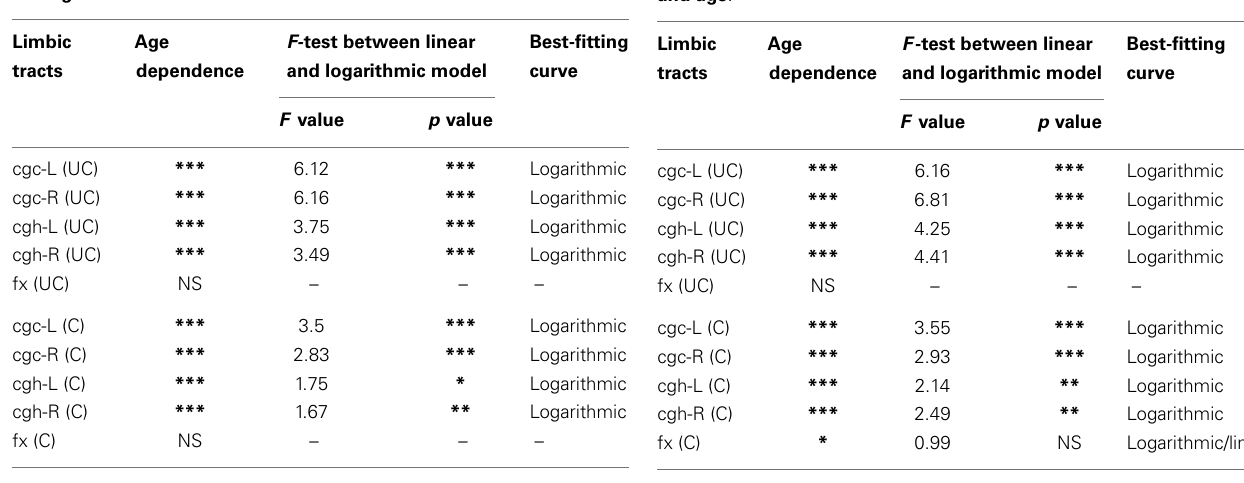
Table 2 | Relationship between mean diffusivity (MD) of limbic tracts and age .